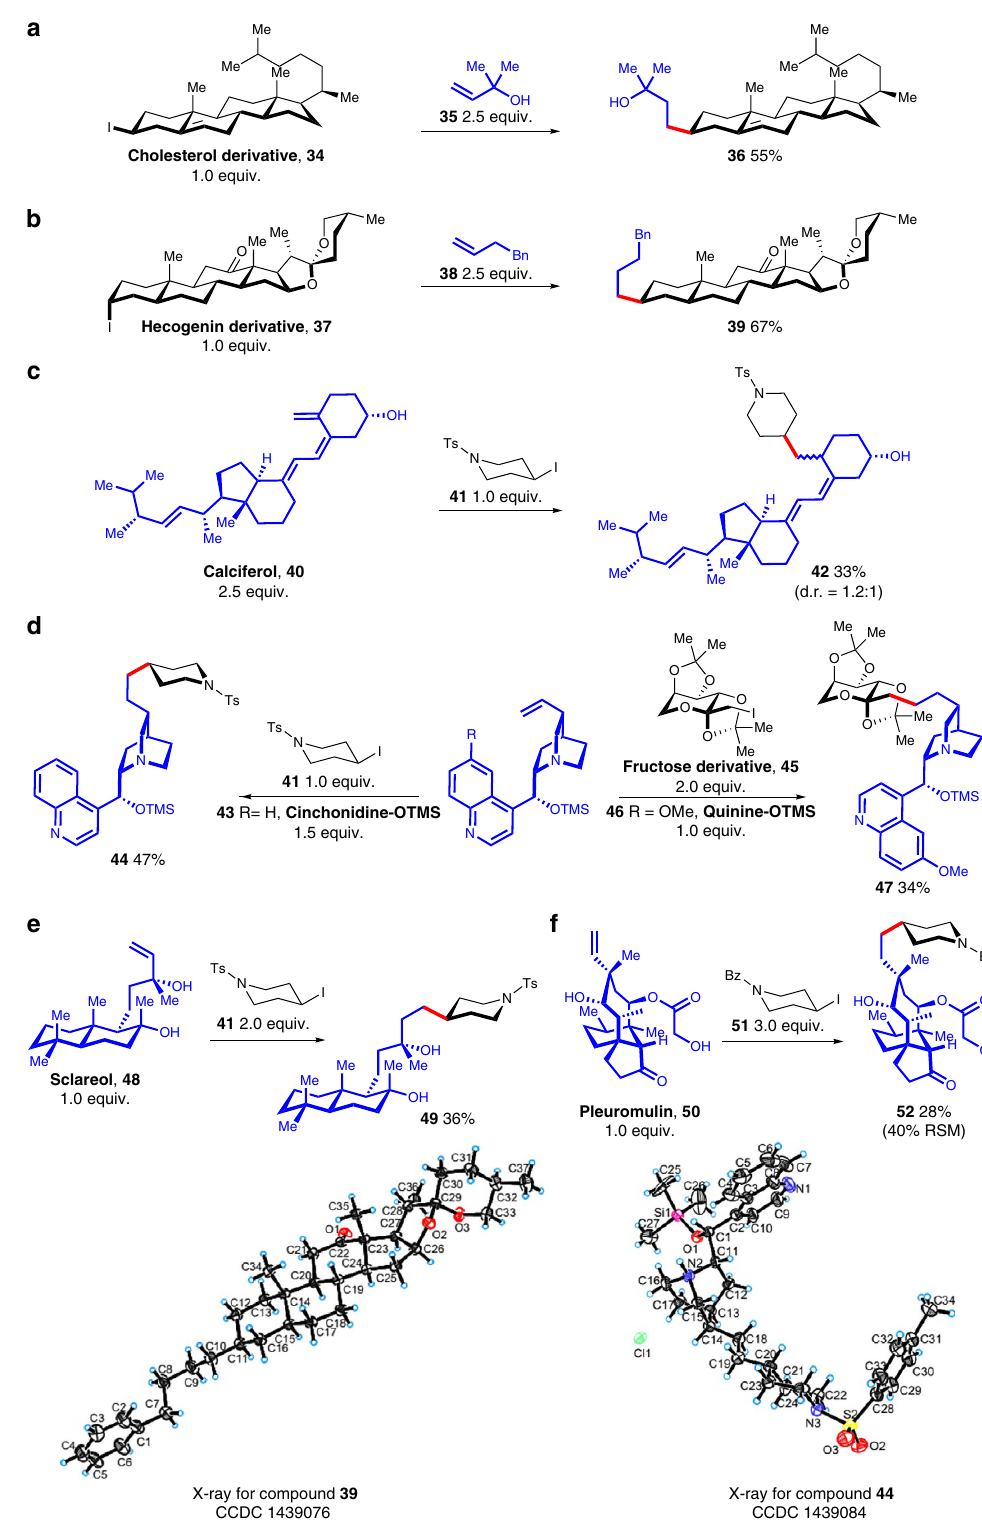
Figure 2 | Modification of complex molecules. ( a ) 10% NiBr 2 .diglyme, 15% L8 , 3.0 equiv. DEMS, 3.0 equiv. Na 2 CO 3 , 2ml DMAc, 30 (cid:2) C, 12h. ( b ) The same conditions as in a the newly formed carbon–carbon bond was between C10 and C11. ( c ) 20% NiBr 2 .diglyme, 30% L8 , 3.0 equiv. DEMS, 3.0 equiv. Na 2 CO 3 , 2ml DMAc, 30 (cid:2) C, 12h. ( d ) conditions for compound 44 : 20% NiBr 2 .diglyme, 30% L8 , 2.0 equiv. DEMS, 2.0 equiv. Na 2 CO 3 , 2ml THF/DMAc (v/v ¼ 1/3), 30 (cid:2) C, 12h, the newly formed carbon–carbon bond was between C19 and C20; conditions for compound 47 : same conditions as in c . ( e ) Same conditions as in c . ( f ) 20% NiBr 2 .diglyme, 30% L8 , 4.0 equiv. DEMS, 4.0 equiv. Na 2 CO 3 , 2ml DMAc, 30 (cid:2) C,